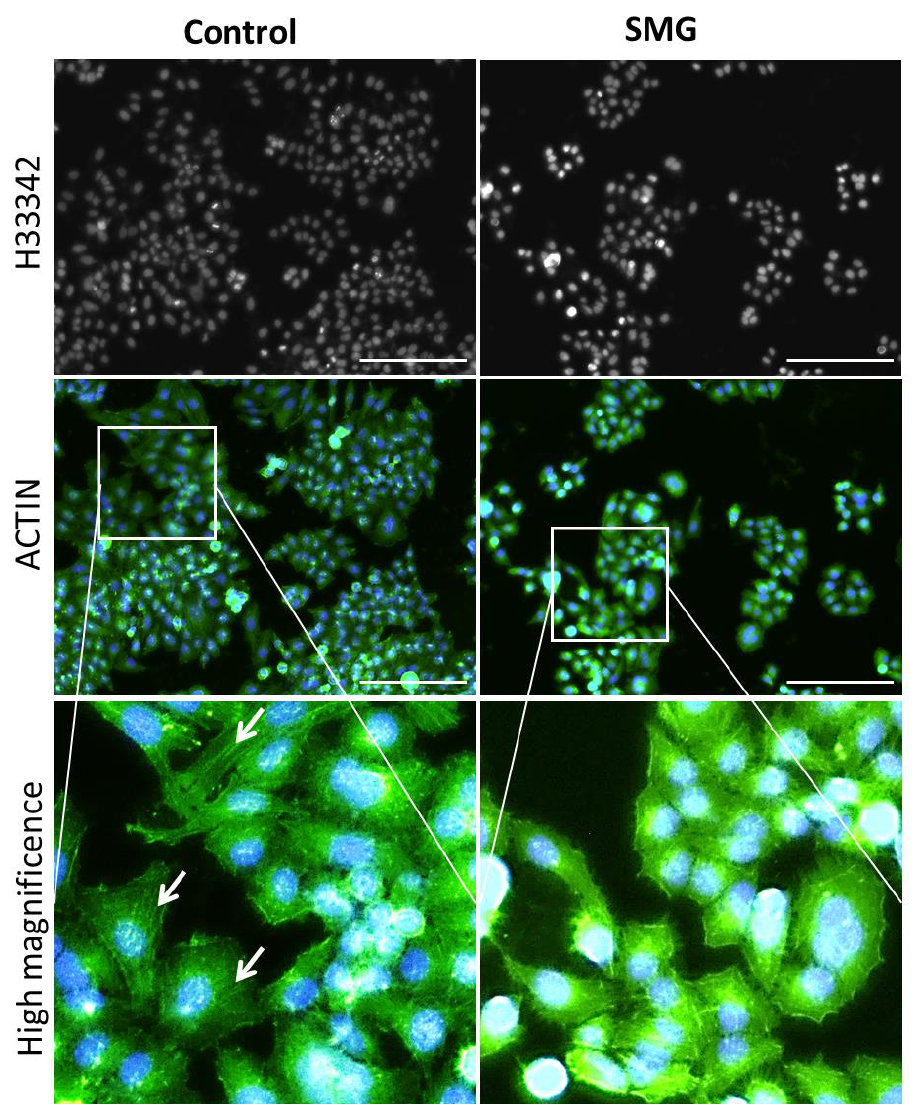
Figure 6. Distribution of microfilament bundles in CCL-13 cells. Nuclei were counterstained with H33342, and microfilaments were counterstained with Phalloidin (green). The white arrows indicate microfilament bundles. Scale bar = 223.64 µm.